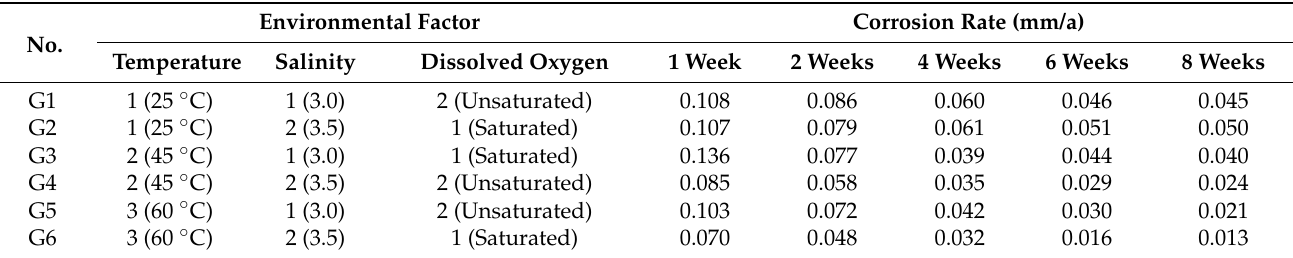
Table 8. The corrosion rate (average value of three parallel specimens) after different test times.